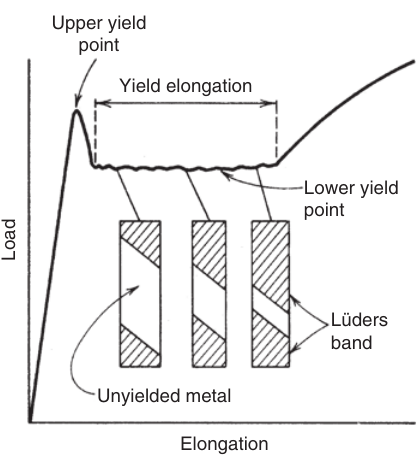
Figure 1: A schematic illustration of the propagation of Lüders bands in a stress-strain curve